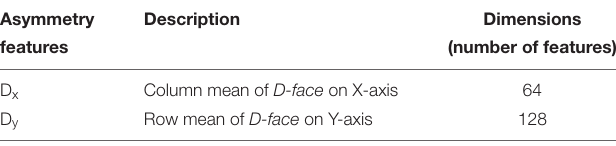
TABLE 2 | The different asymmetry features based on